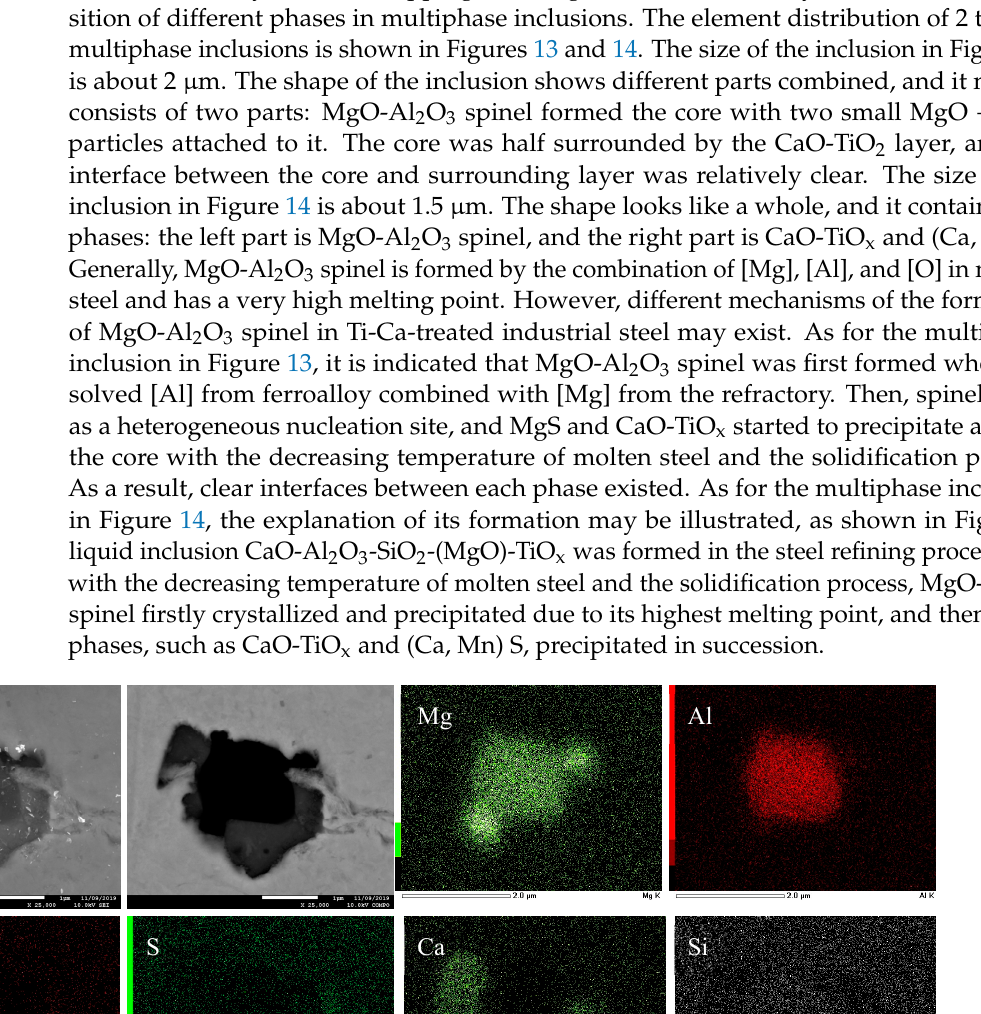
Figure 14. The element distribution of typical multiphase inclusion. A large-sized multiphase inclusion is shown in Figure 15 and the results of EPMA analysis for each phase are listed in Table 5. The main body of this large-sized inclusion consisted of CaO-Al 2 O3-SiO 2 (red number 1) and CaO-TiO x (red number 2). It seemed that this large-sized inclusion was crushed and separated into several parts composed of (Ca, Mn)S (red number 3), CaO-Al 2 O 3 -MgO (red number 4) and CaO-SiO 2 (red number 5) dur- ing the rolling process of TMCP, so it spread along the rolling direction.